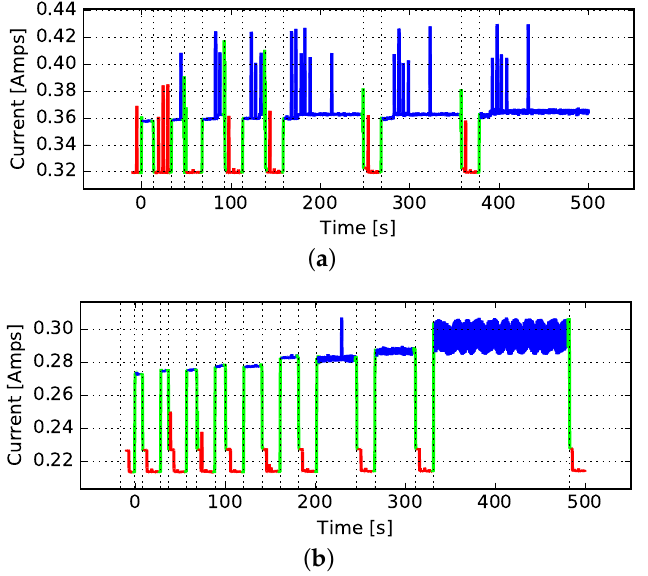
Figure 8. Electric current for each Raspi model. ( a ) Electric current for the Raspi 1 model; ( b ) electric current for the Raspi 2